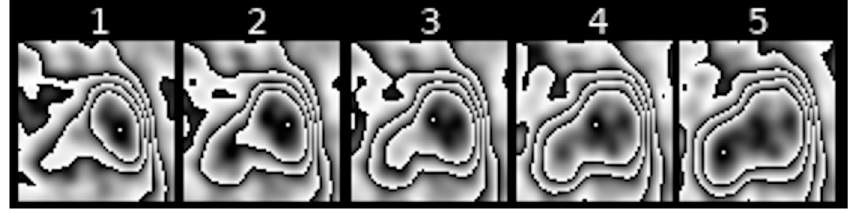
Figure 6. Example of a sequence of transformed PET images of a pulmonary nodule with moderately altered shape of [18F] FDG uptake contours. Figure 7. Example of a sequence of transformed PET images of a pulmonary nodule with slightly altered shape of [18F] FDG uptake contours. 2.7. Shifts in the Area of Maximum [18F] FDG Uptake within Nodule Borders (Feature III) Feature III refers to the change in the location of the area with maximum [18F] FDG uptake within the contour that surrounds it in subsequent scans of transformed PET im- ages of pulmonary nodules. Figures 8–10 show examples of such shifts in the location of maximum uptake. Figure 8. Example of a considerable shift in the location of maximum [18F] FDG uptake in a se- quence of PET images of a pulmonary nodule.